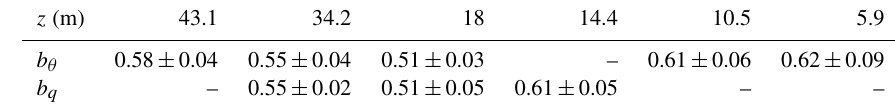
Table 2. REA coefficients measured within the roughness sublayer (Gao, 1995).